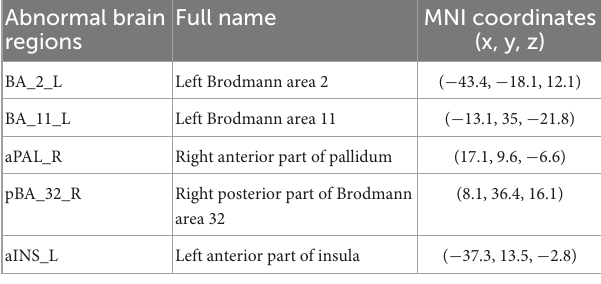
TABLE 3 The MNI coordinates of between-group functional connectivity differences of brain regions. Abnormal brain